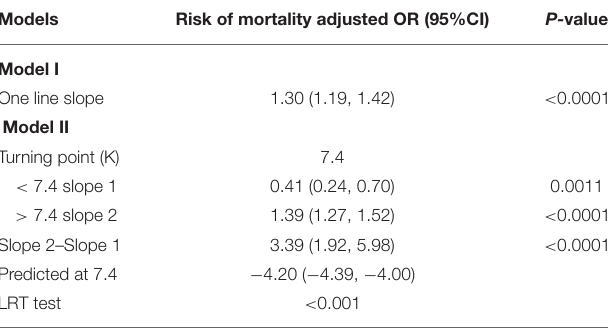
TABLE 3 | Threshold effect analysis for the relationship between magnesium (per 0.1 mmol/L) and 28-day in-hospital all-cause